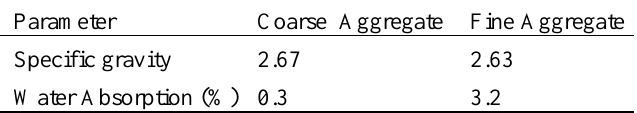
Specific gravity and water absorption values of aggregates Parameter Coarse Aggregate Fine Aggregate